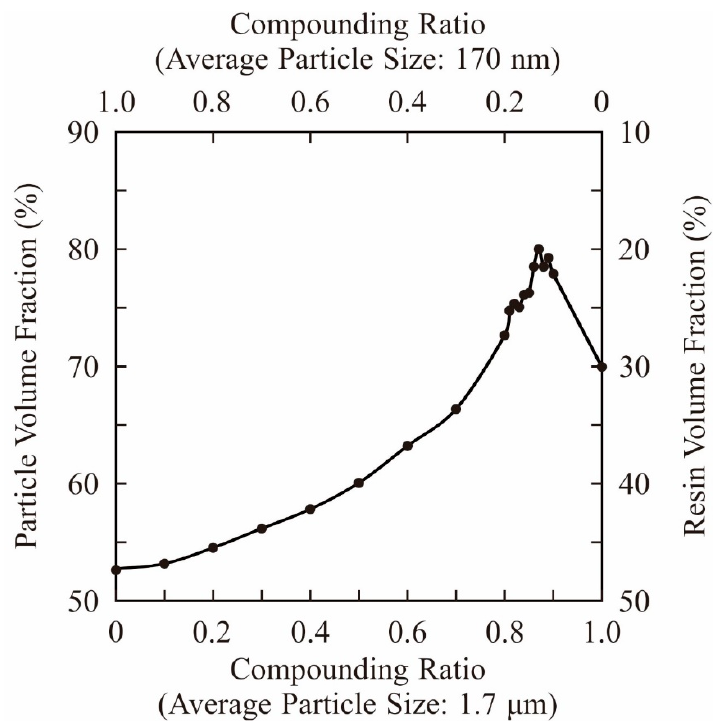
Figure 3. Volume fractions at compounding ratios. Binary particle sizes of 170 nm and 1.7 μ m in diameters were adjusted. Closed packs of spherical fillers were simulated by a distinct element method (DEM).